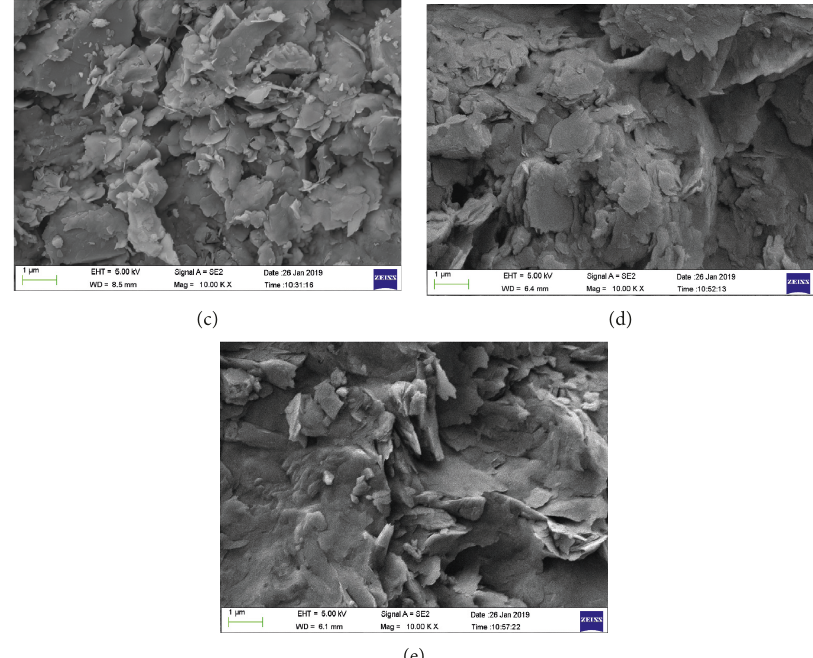
Figure 15: SEM images of the sandstone specimen after 15 cycles of wetting and drying in different water temperatures. (a) 20 ° C. (b) 40 ° C. (c) 60 ° C. (d) 80 ° C. (e) 98 °